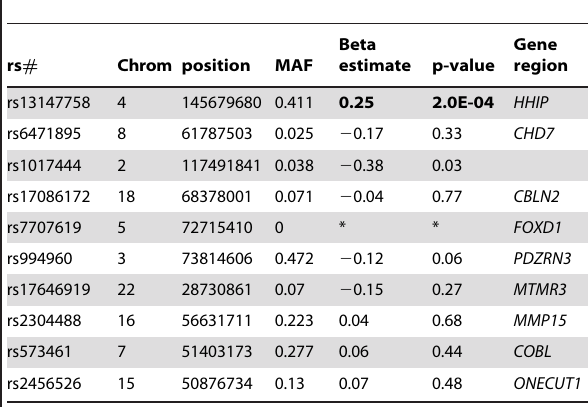
Table 3. Association results for SNPs in the top 10 GWA regions identified in Framingham and examined in 835 Family Heart Study participants for association to percent